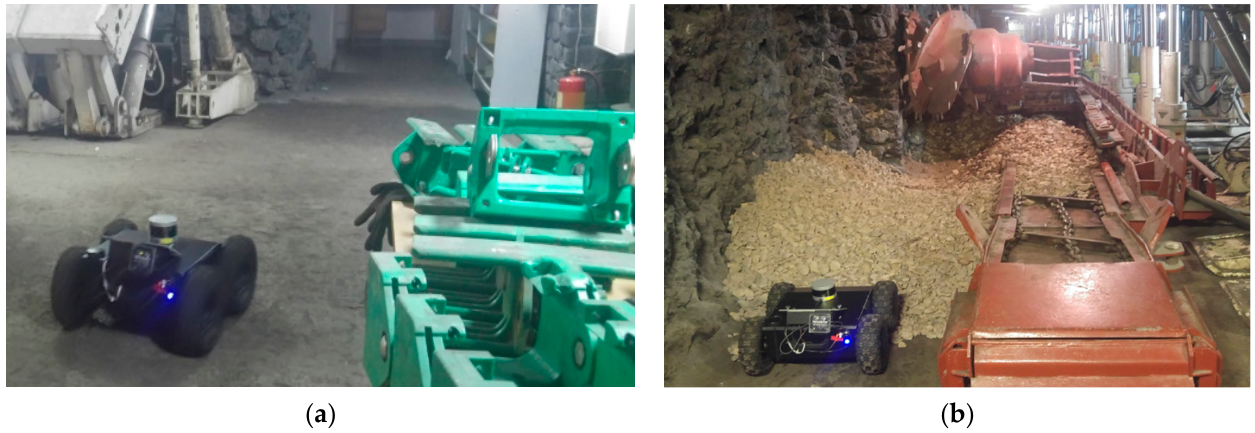
Figure 4. Underground inspection scenarios: ( a ) smooth terrain before accident; ( b ) rough terrain after accident.